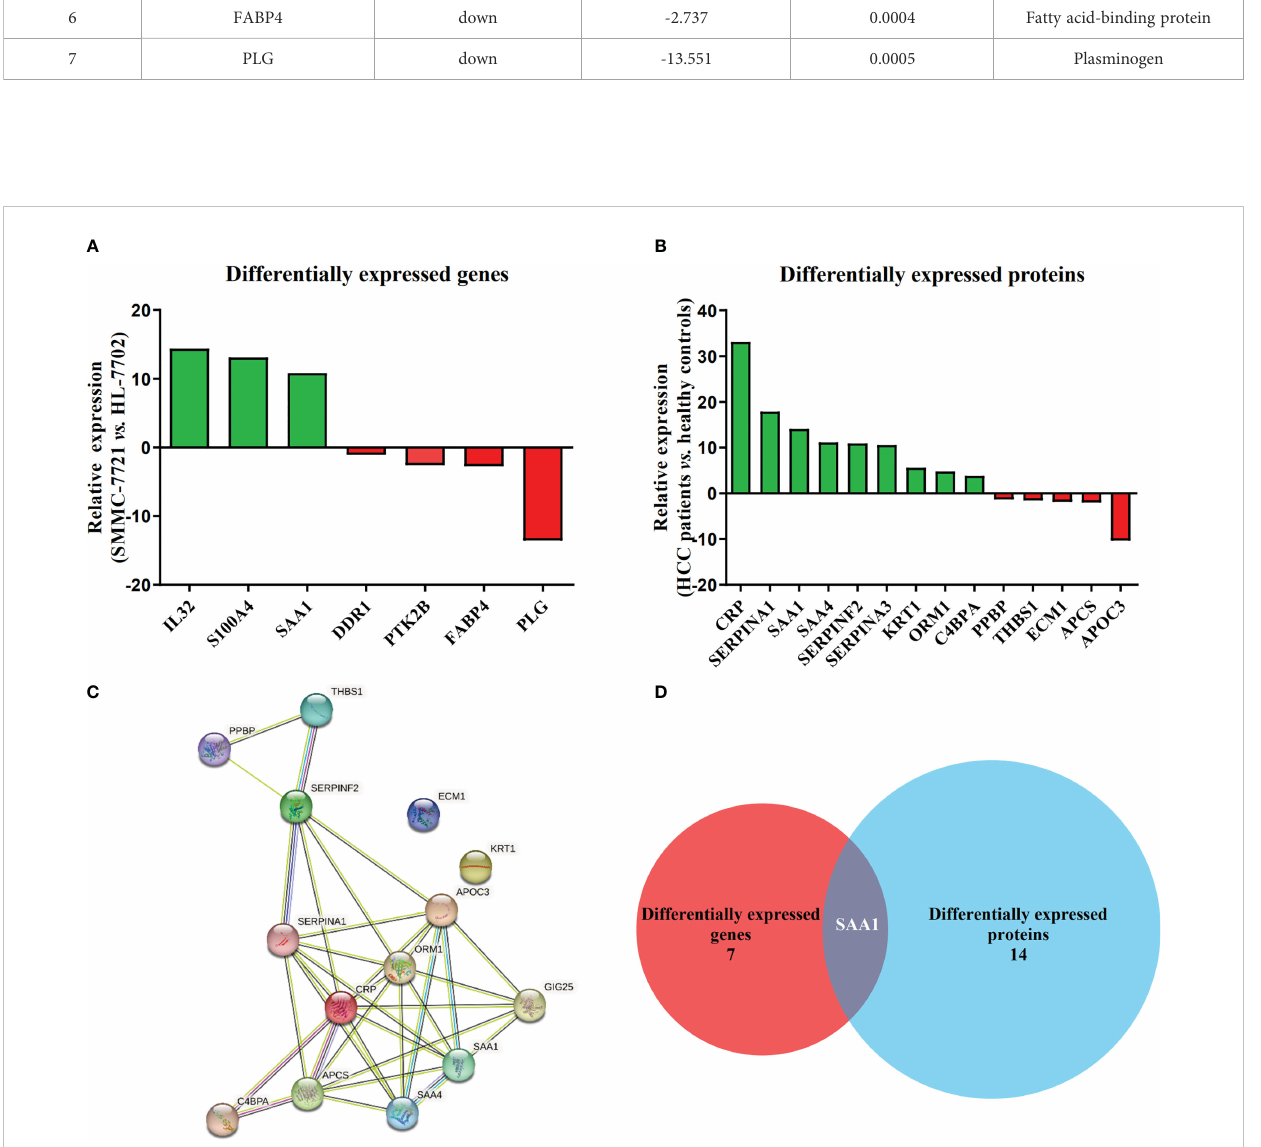
FIGURE 2 SAA1 listed as an HCC metastasis candidate biomarker. (A) Relative expression of 7 DEGs associated with HCC metastasis in HCC cell line SMMC- 7721, when compared with normal liver cell line HL-7702. (B) Relative expression of 14 DEPs associated with HCC metastasis in HCC patient serums (n = 10), when compared with healthy controls (n = 10). (C) Constructed protein – protein interaction (PPI) network of DEPs related to HCC metastasis using Search Tool for Retrieval of Interacting Genes/Proteins (STRING) database. (D) SAA1 was listed as common key gene by the Venn diagram